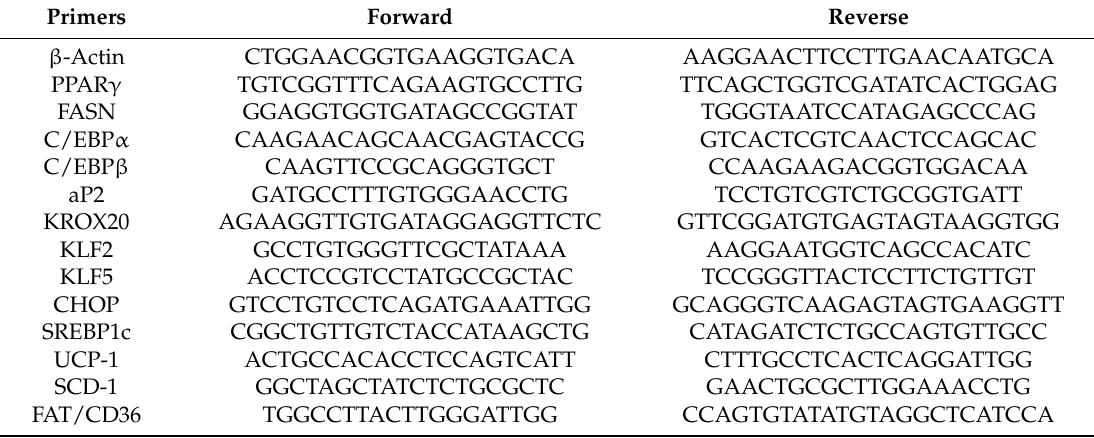
Table 1. Primers used in qRT-PCR. C/EBP = CCAAT/enhancer binding protein; KLF = Krüppel-like factor; FAT/CD6 = fatty acid translocase. SREBP1c = sterol regulatory element-binding protein 1c. CHOP = C/EBP homologous